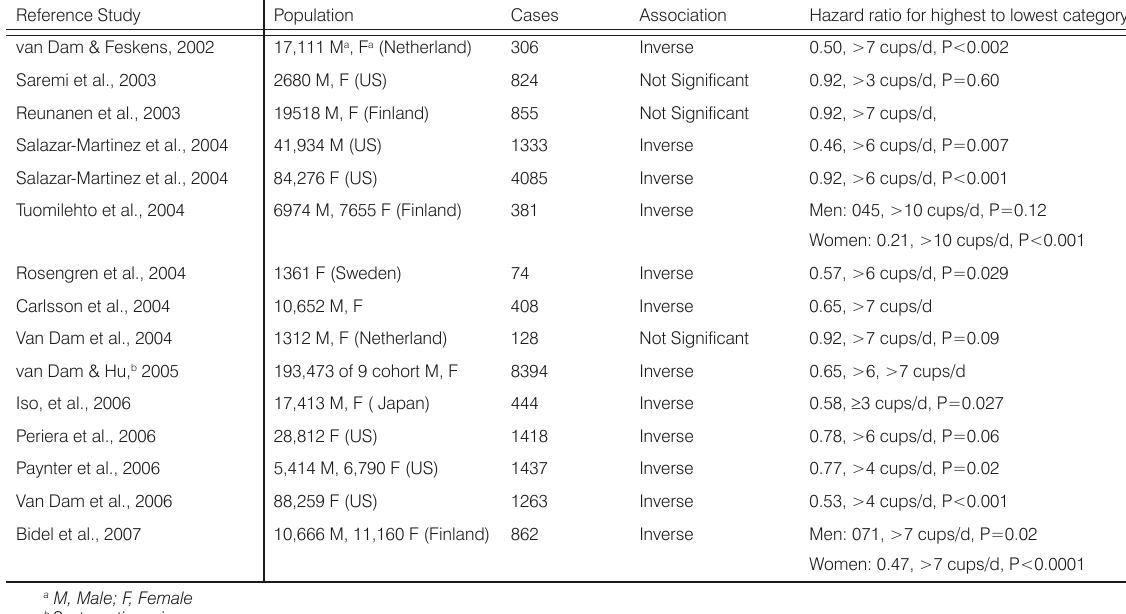
Figure 1. Relative risk of type 2 diabetes according to joint effects of coffee consumption, physical activity and BMI. Cox proportional hazards model adjusted for age, study year, sex, education, systolic blood pressure, bread consumption, frequency of vegetable consumption, frequency of fruit consumption, frequency of sausage consumption, tea and alcohol consumption, and smoking. Inactivity was defined as low physical activity; activity was defined as moderate or high physical activity. *p <0.05 compared with referent group [63